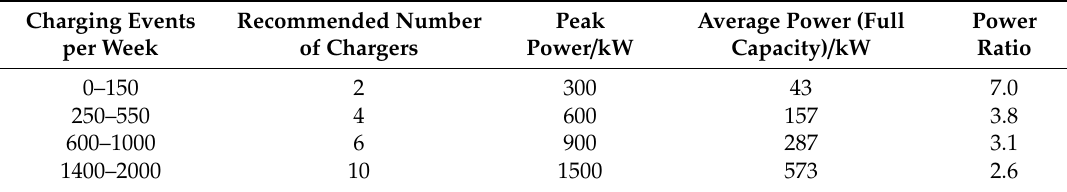
Table 1. Peak-to-average ratio for various stations